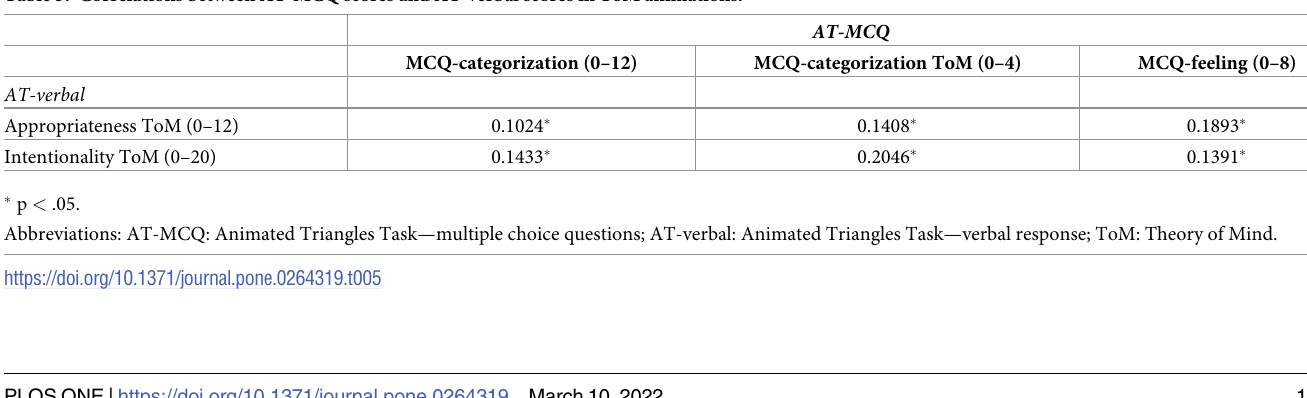
Table 5. Correlations between AT-MCQ scores and AT-verbal scores in ToM